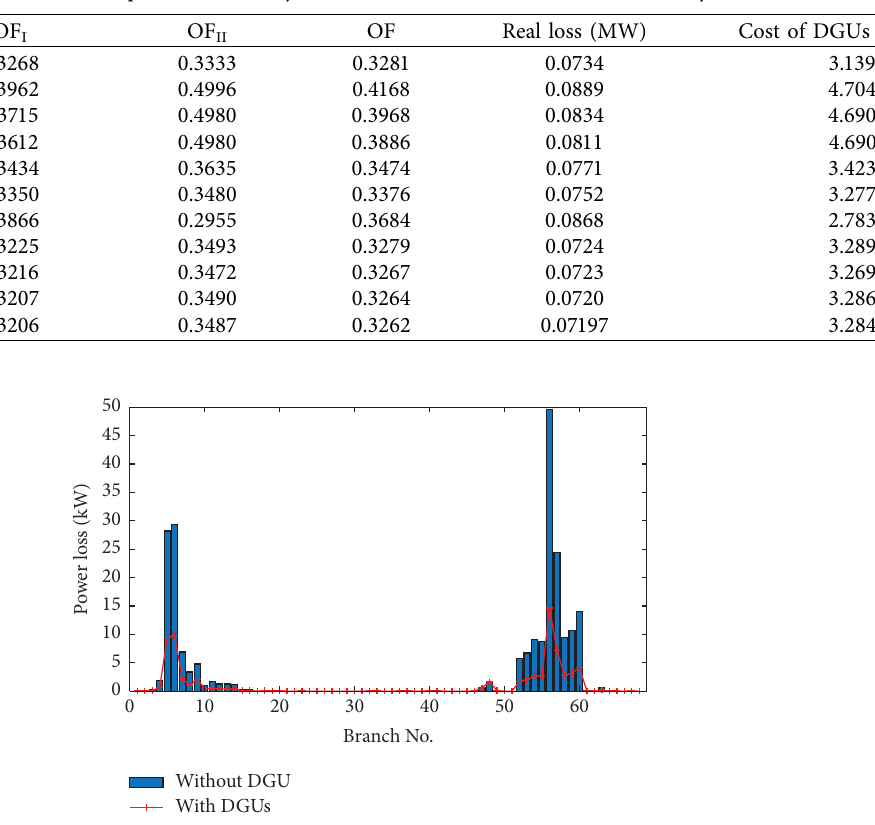
Table 6: Te comparison of the objective function values for the IEEE 69-bus system.